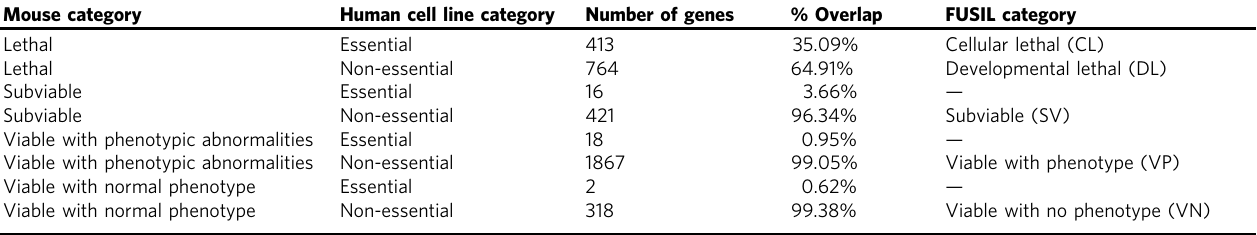
Table 1 FUSIL categories.